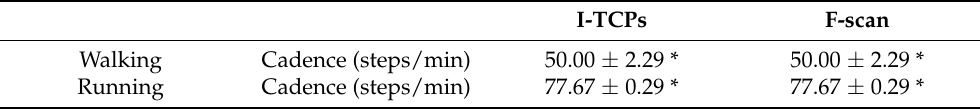
Table 3. Result of a static gait index comparison between I-TCPs and